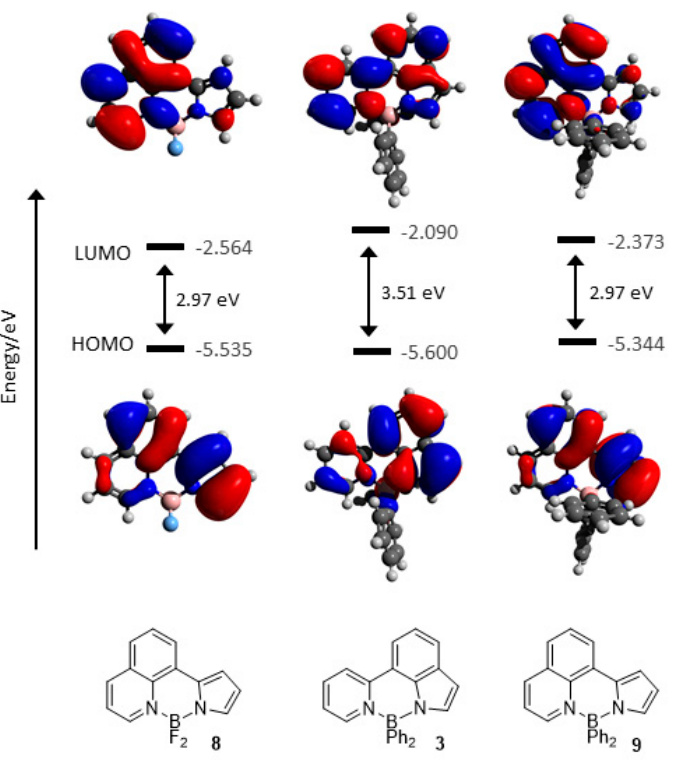
Figure 5. HOMO and LUMO molecular orbitals and energies (eV) for 8 and 9 together with those for the indolopyridine 3 for comparison. Calculated by DFT at the B3LYP/def2-TZVPP level using ORCA [42].